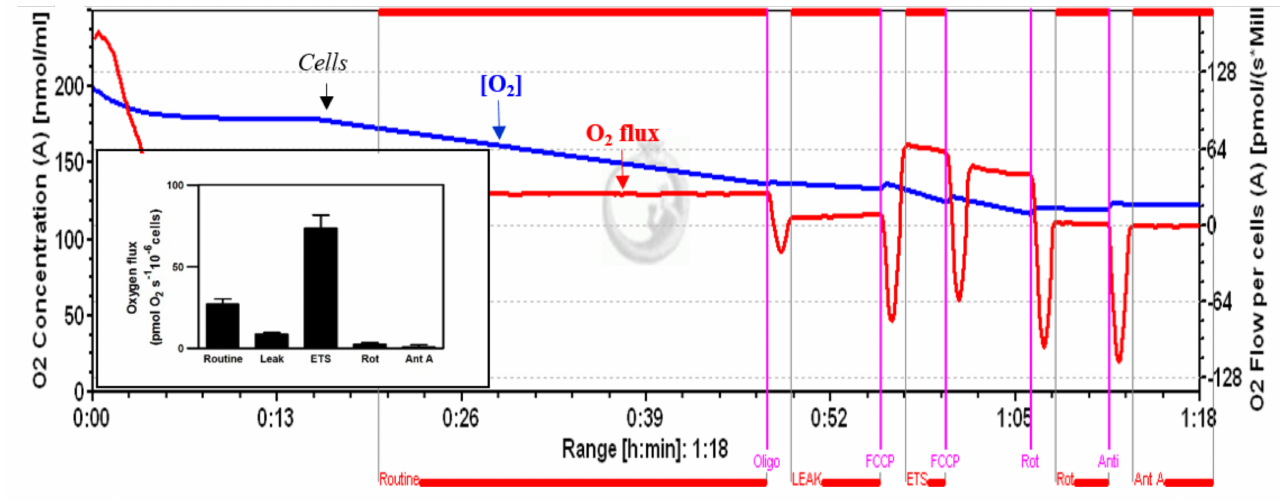
Figure 3. A typical profile of cellular respiration of untreated HepG2 cells, recorded by high-resolution respirometry, with traces of oxygen concentration (blue line) and oxygen flux (red line), corrected for instrumental background. Vertical lines represent responses to additions of oligomycin (Oligo), which reduced respiration to the LEAK state (inhibition of ATP synthase); FCCP, which stimulated respiration in the non-coupled state of the ETS; a second FCCP titration illustrates the inhibition by excess uncoupler concentration; and inhibition by rotenone (Rot) and antimycin A (Ant A). The inset shows a bar graph of the different phases of oxygen